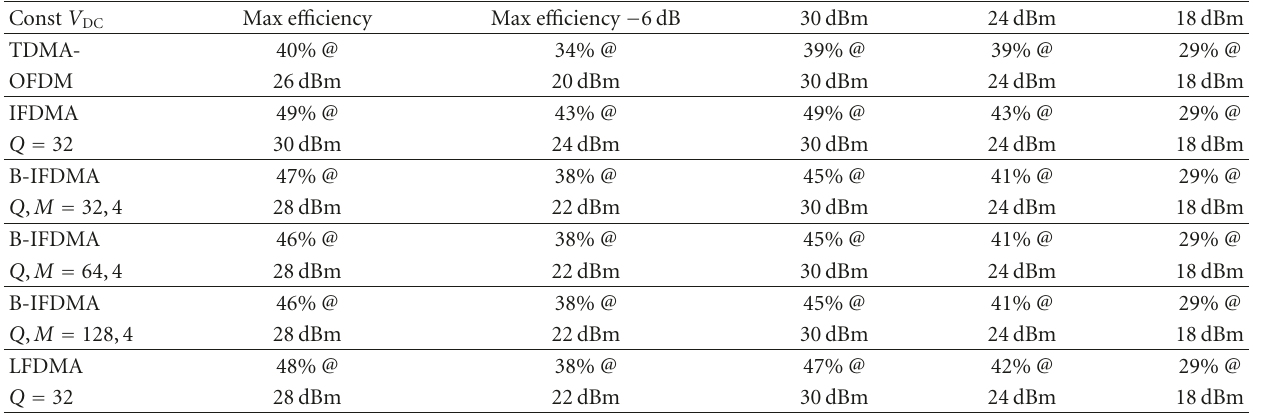
Table 3: Overall e ffi ciency η A in % of the HPA in [42] with constant drive voltage operation with V DC chosen for maximum overall e ffi ciency for di ff erent input signals, all using QPSK symbol constellations and a system with N = 1024 subcarriers.